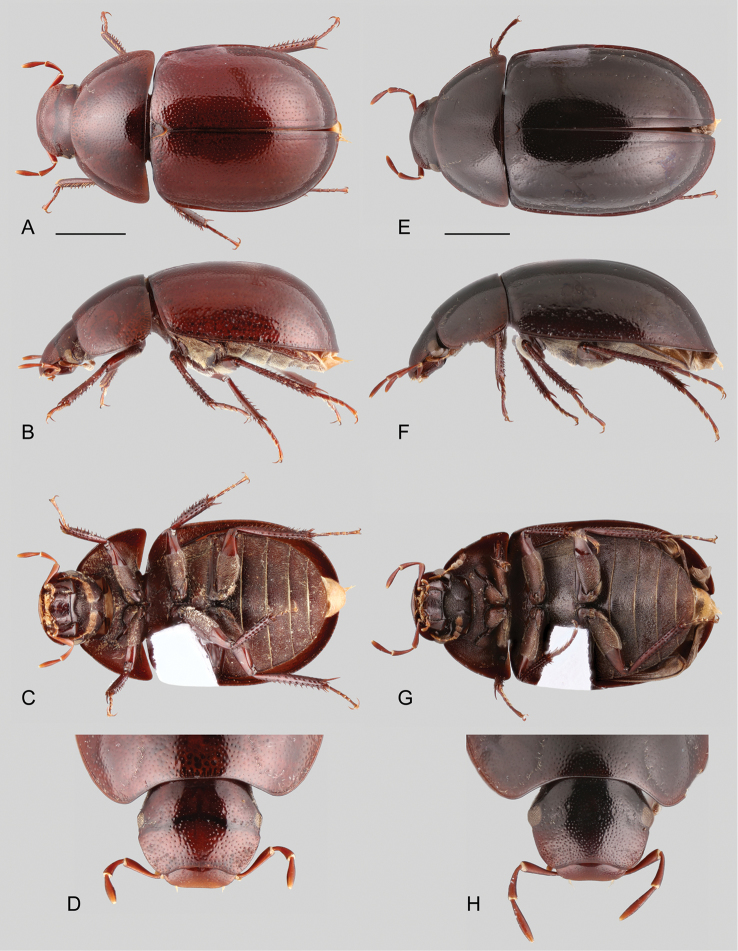
Habitus of Primocerus spp.: A–DPrimocerusocellatus: A dorsal view B lateral view C ventral view D head, dorsal view. E–HPrimocerusgigas: E dorsal view F lateral view G ventral view H head, dorsal view. Scale bars: 1 mm.